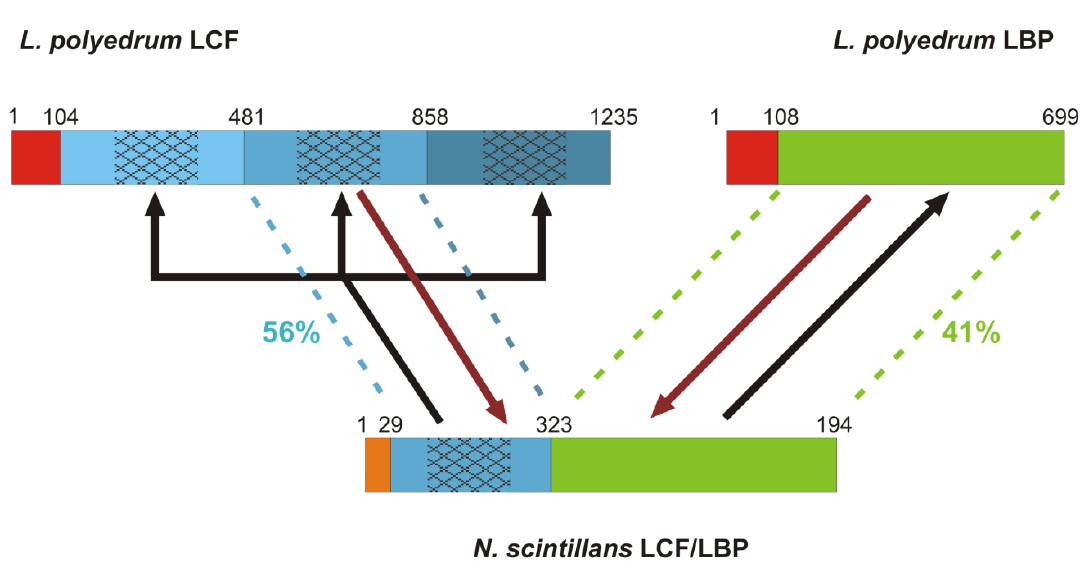
Figure 2. A schematic representation of the different LCF and LBP structures labeled with amino acid positions and the two scenarios for their evolution [30,32]. Lingulodinium polyedrum LCF represents the photosynthetic dinoflagellates in general [30]. The three non-identical repeat domains of L. polyedrum LCF (different shades of blue) are each 377 amino acids long with 150 amino acids in the central regions that encode the catalytic sites (patterned) and retain higher sequence similarity. The single LCF domain of N. scintillans is most similar to the second domain of L. polyedrum LCF. The LBP domain in N. scintillans is structurally equivalent to that in L. polyedrum , both consisting of four repeat domains. In both organisms, LCF is preceded by an N -terminal gene region which is similar in the LCF and LBP of L. polyedrum (red) but not in N. scintillans (orange). Two potential scenarios of how these gene structures arose are shown. In the gene fission scenario (black line), the N. scintillans gene split and the LCF domain underwent successive duplications. In the gene fusion scenario (brown lines), the second domain of LCF was excised (e.g., by splicing) and fused with LBP in N. scintillans